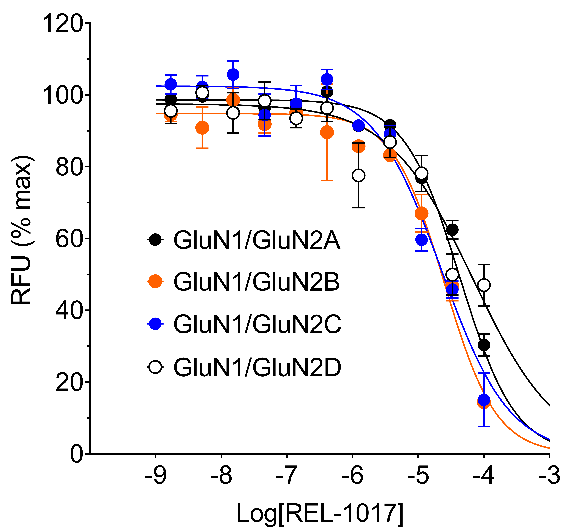
Figure 1. REL-1017 concentration-response curve (CRC) was performed in the presence of 10 µM L-glutamate and 10 µM glycine but in the absence of extracellular Mg 2+ by fluorometric imaging plate reader (FLIPR) Ca 2+ assay using Chinese hamster ovary (CHO) cell lines expressing the indicated heterodimeric N-methyl-D-aspartate receptors (NMDARs). REL-1017 caused a decrease in the in- creased intracellular Ca 2+ elicited by 10 µM L-glutamate with estimated IC 50 concentrations of 43 µM, 23 µM, 23 µM, and 68 µM for 2A-, 2B-, 2C-, and 2D-containing NMDARs, respectively. 100 μ M REL-1017, the maximal tested concentration, reduced Ca 2+ influx by 30%, 14%, 15%, and 47% of that evoked by 10 µM L-glutamate for NR1-2A, NR1-2B, NR1-2C, and NR1-2D subtypes, respectively. Fitting parameters for REL-1017 and other known NMDAR blockers, which were tested in identical conditions, are reported in Table 1. Data are mean ± standard error of the mean (SEM), n = 6 per group, and were fitted using the four-parameter logistic equation with GraphPad Prism v8.0. RFU is relative fluorescence units.